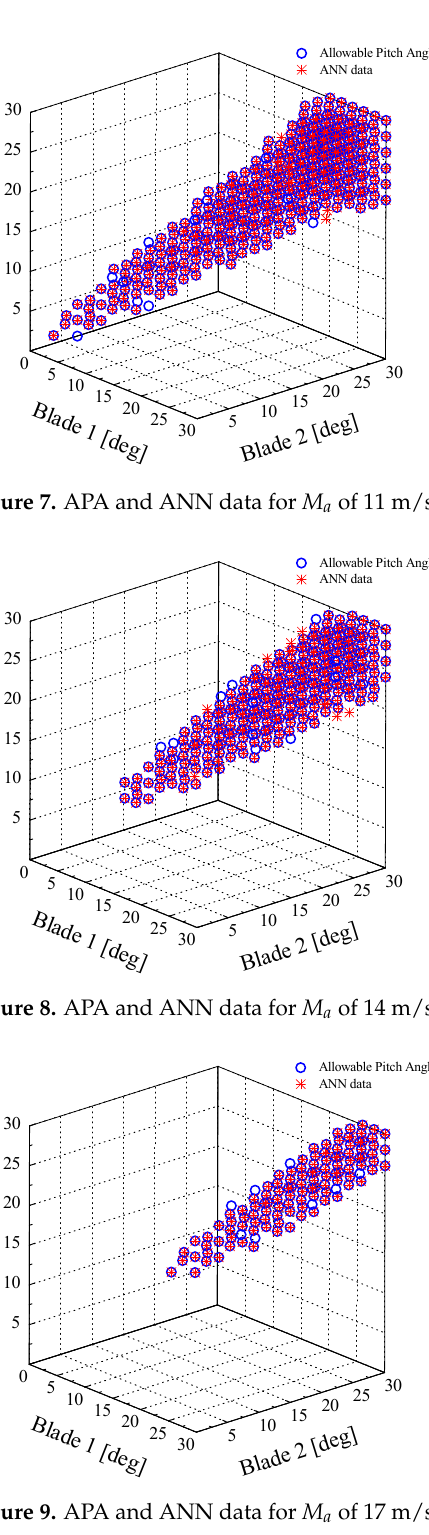
Figure 9. APA and ANN data for M a of 17 m/s.